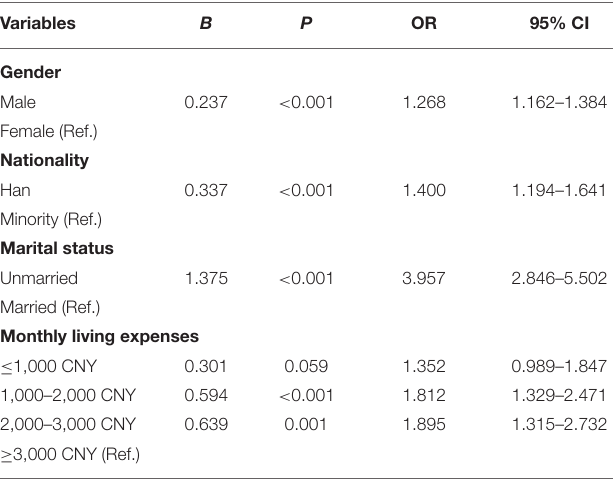
TABLE 3 | Multivariate unconditional logistic regression on awareness of HIV health education knowledge.